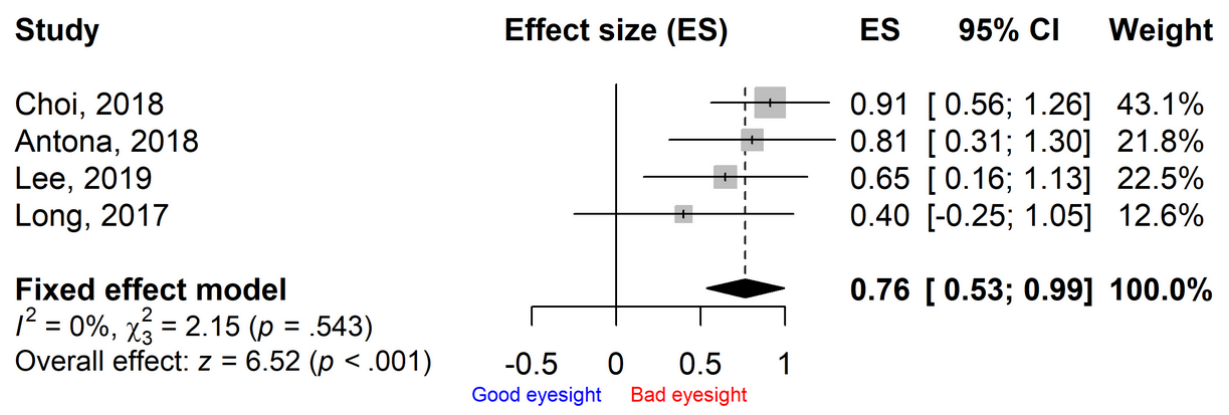
Figure 7. Pooled effect size (ES) of visual function score in the smartphone overuse group compared to the reduced-use